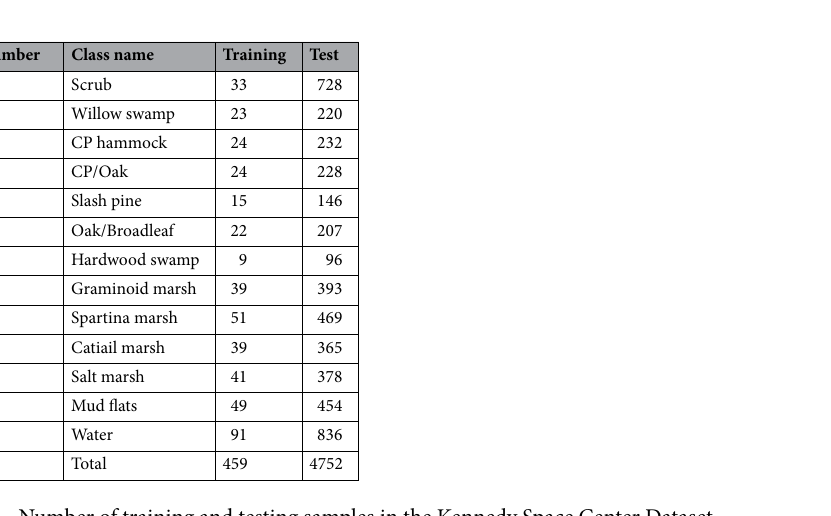
Table 3. Number of training and testing samples in the Kennedy Space Center Dataset.